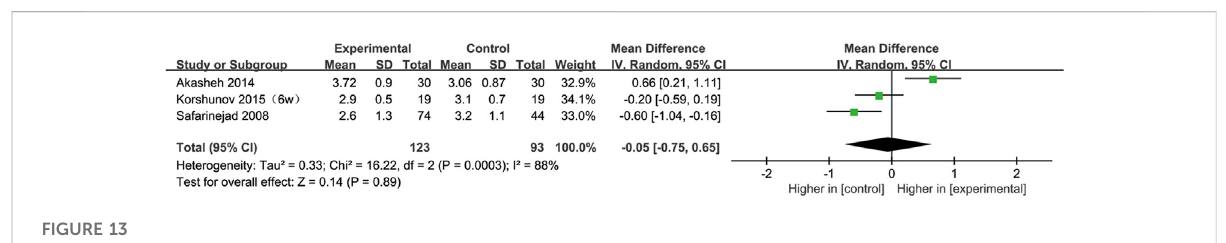
Forest plot for the association between SSRIs used and semen